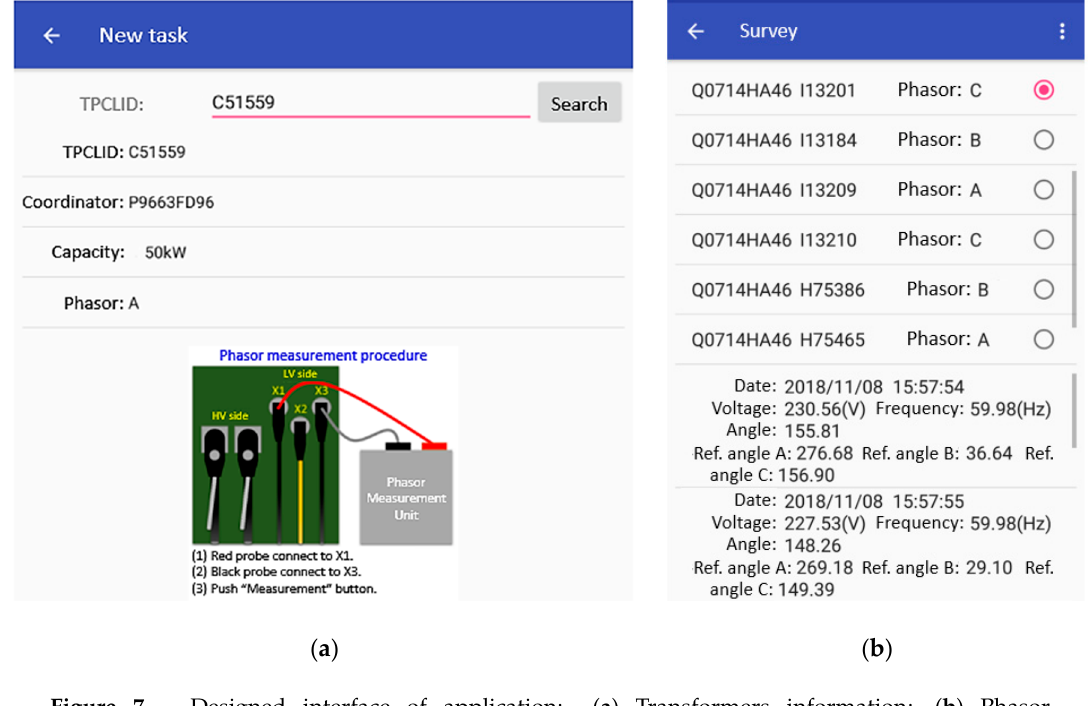
Figure 7. Designed interface of application: ( a ) Transformers information; ( b ) Phasor identification results. identification